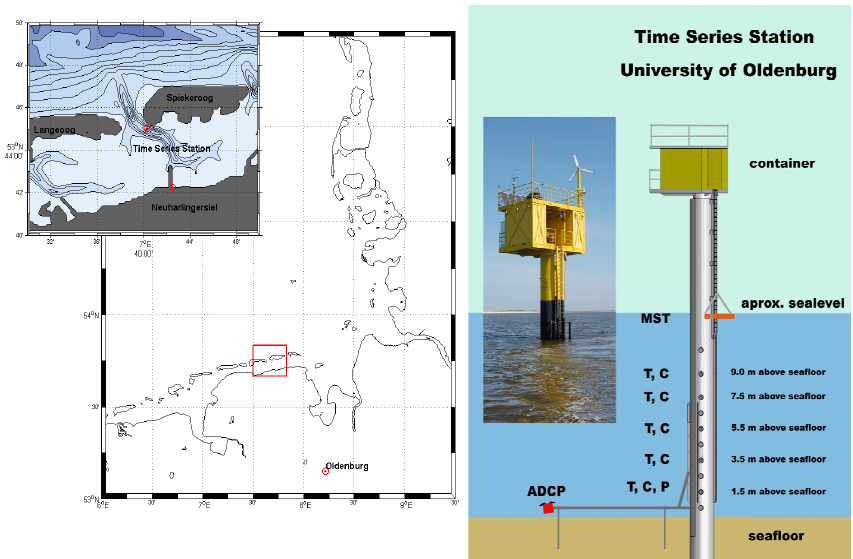
Figure 1. Left: Time Series Station Spiekeroog in the tidal inlet between the East Frisian islands Spiekeroog and Langeoog. Right: schematic of the Time Series Station Spiekeroog with attached sensors; T: temperature sensor; C: conductivity sensor; P: pressure sensor, ADCP: acoustic Doppler current profiler, MST: Multispectral Transmissometer. (Badewien et al., 2009)